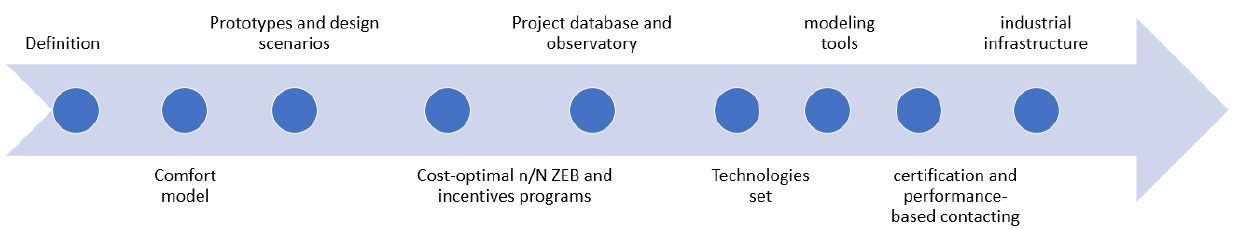
Figure 1. Industrial countries roadmap [1].